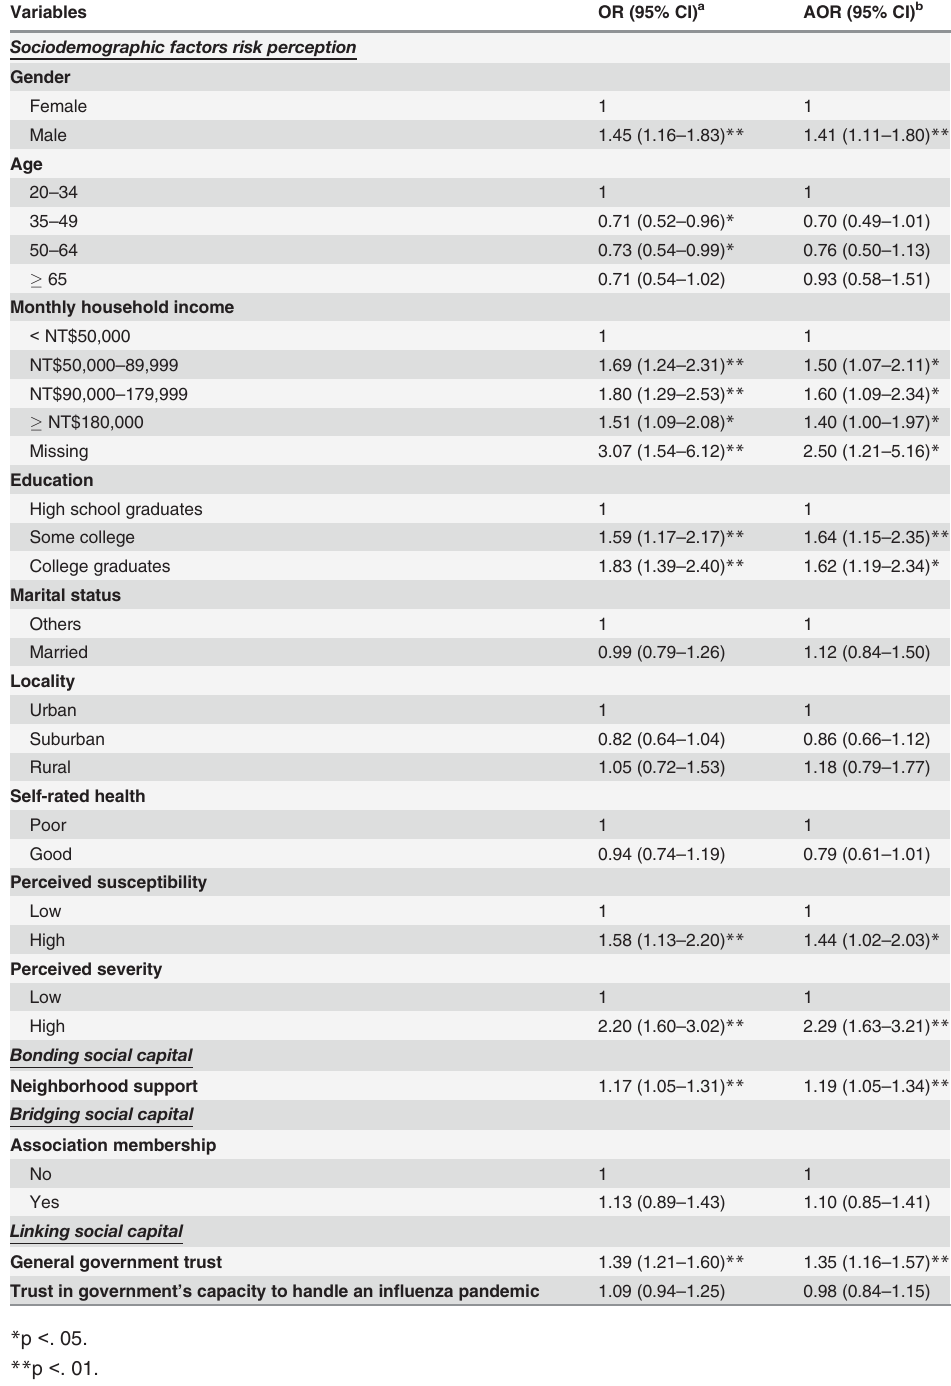
Table 2. Association between social capital, sociodemographic factors, risk perception, and the in- tention to receive